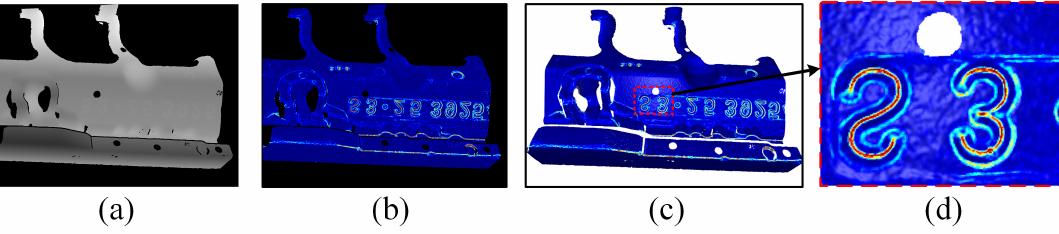
Figure 2. ( a ) A depth map acquired with the FPP sensor, ( b ) Its corresponding curvature map estimated using our method, ( c ) The rendered 3D point cloud with its color mapped from the curvature map, ( d ) Local details of curvature information at local point cloud